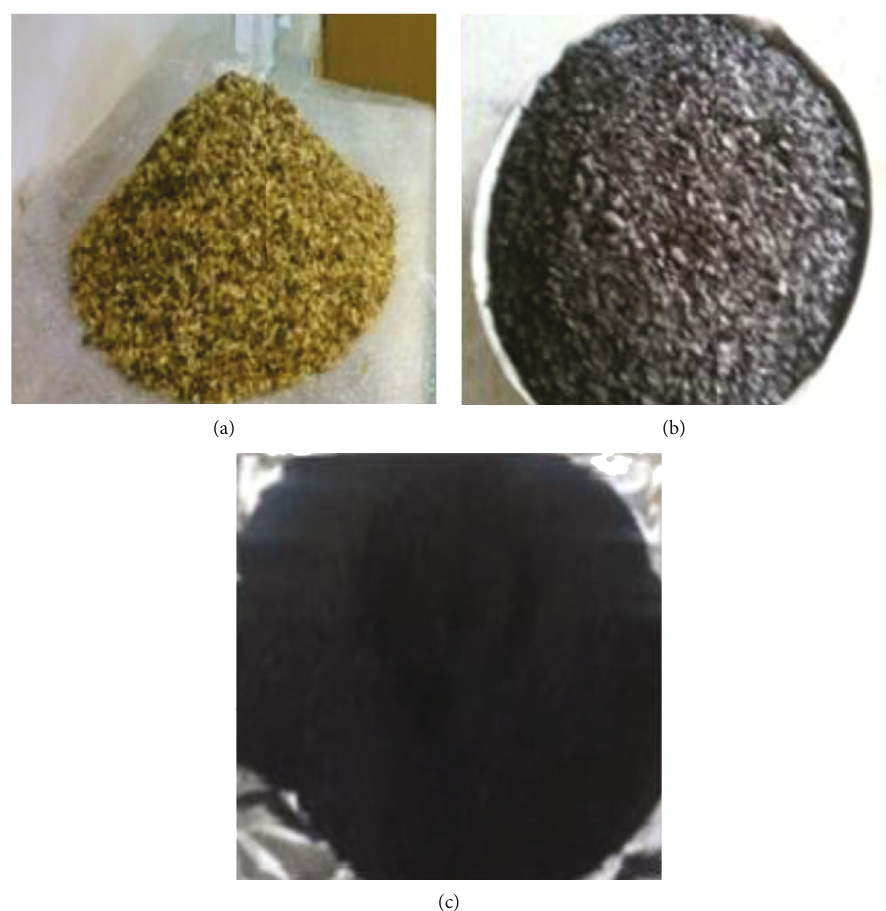
Figure 1: Photo of (a) raw co ff ee husk, (b) activated co ff ee husk carbon, and (c) Powdered activated co ff ee husk